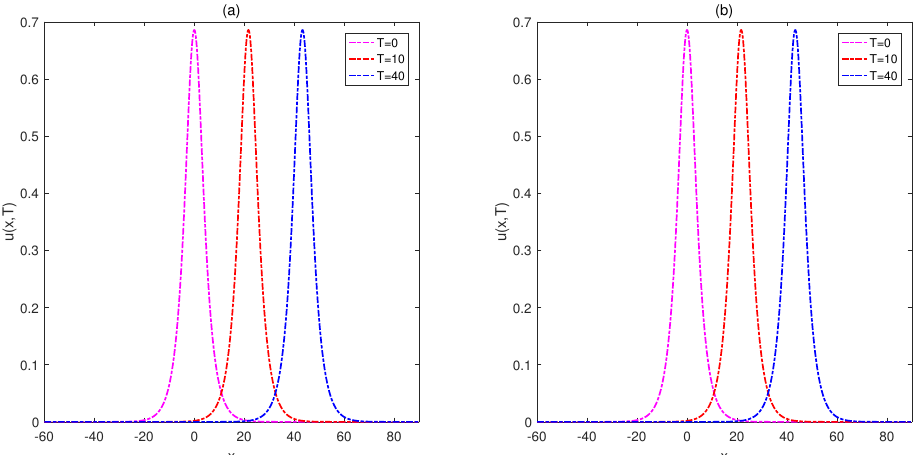
Figure 6. Motion of the single solitary wave with h = τ = 0.125 ( a ) and h = τ = 0.0625 ( b ) over the interval x ∈ [ − 60,90 ] at final times T ∈ { 0,10,40 } for Example